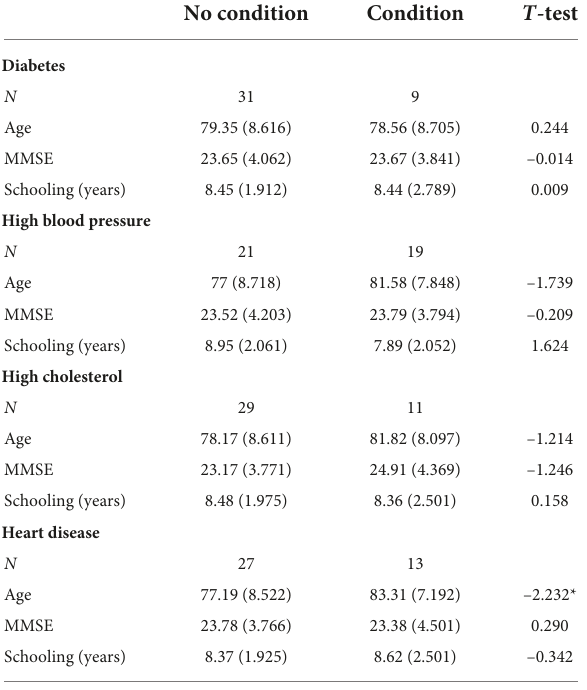
TABLE 1 Characteristics of the sample divided by the presence or absence of each of the conditions